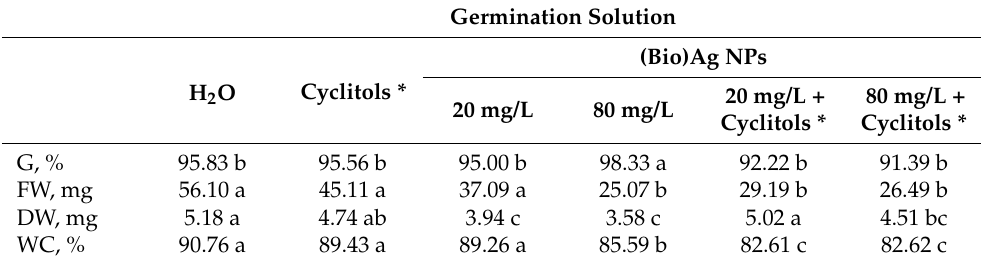
Table 2. The germinability (G), fresh weight (FW), dry weight (DW) and water content (WC) in seedlings of wheat ( Triticum aestivum L. cv. Ostka Strzelecka) developing for 3 days in double-distilled water (DDW), (Bio)Ag NPs (at 20 and 80 mg/L), cyclitols (each at 100 mM) and mixtures of (Bio)Ag NPs and cyclitols (data for cyclitols are means from treatment with MIN, DCI and PIN). Values are means of three replicates. The same letters by the values indicate that there were no significant ( p < 0.005) differences after ANOVA test and Tukey’s post hoc corrections.